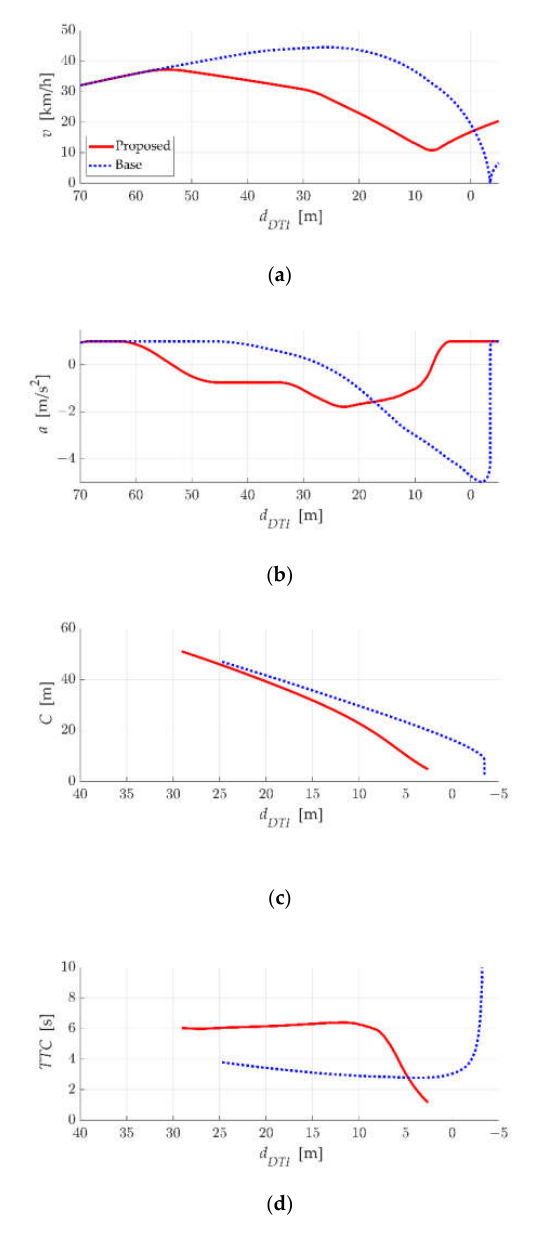
Figure 7. Simulation results for LTAP scenario. ( a ) Longitudinal velocity, ( b ) longitudinal accelera- tion, ( c ) clearance to conflict point, ( d ) TTC to conflict point.